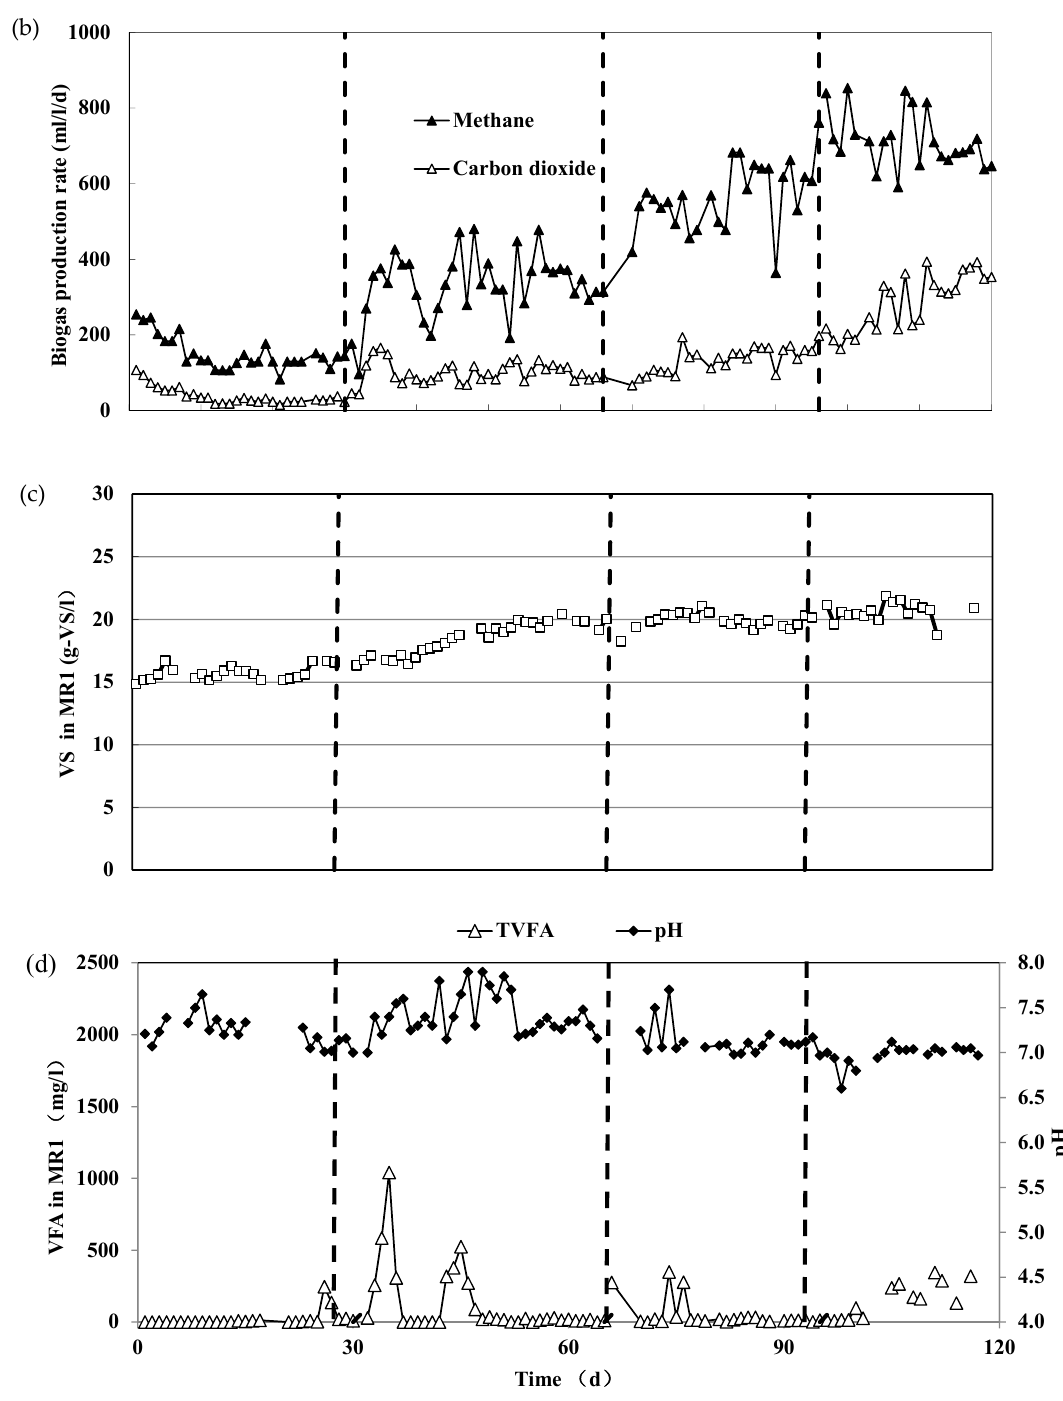
Figure 3. Time courses of biogas production rate, VS, pH and total volatile fatty acid (TVFA) in MR1 at various HRT and OLR. ( a ) HRT and OLR conditions in MR1; ( b ) Methane and carbon dioxide production rate in MR1; ( c ) VS concentration in MR1; ( d ) TVFA content and pH in MR1.